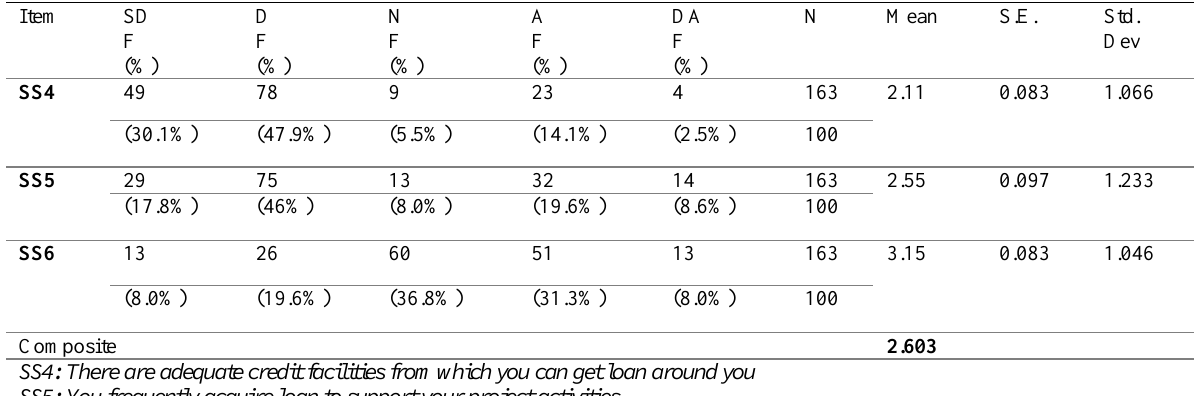
Table 2: Access to credit services and sustainability of